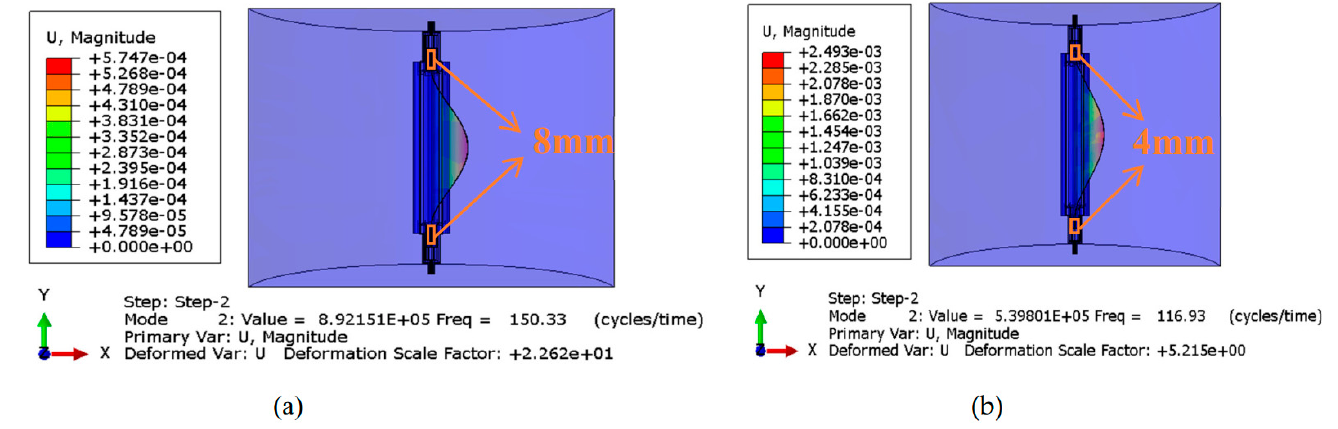
Figure 5. First-order natural frequency of fiber laser encapsulated in polyurethane. ( a ) polyurethane height 8 mm ( b ) polyurethane height 4 mm.